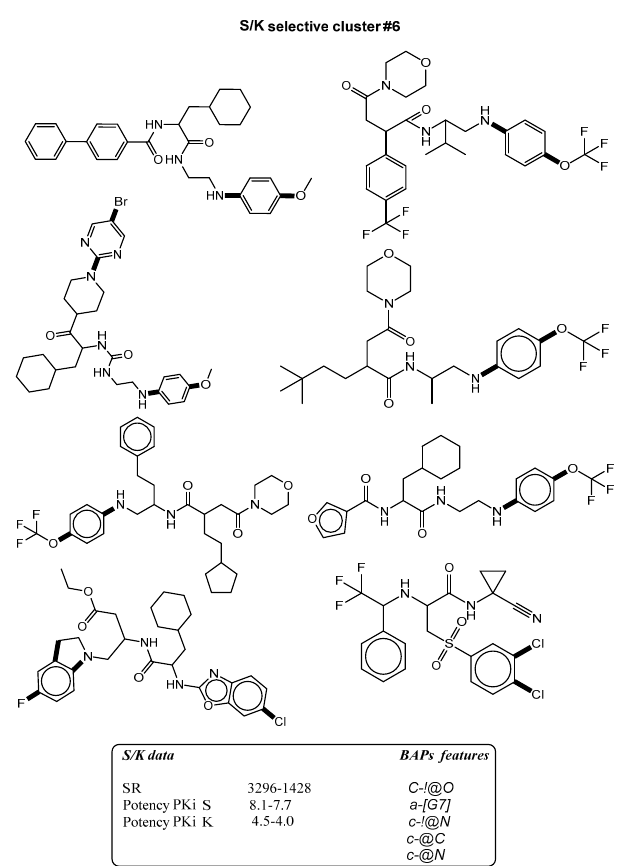
Figure 3. The figure shows mapping of representative BAPS selectivity signatures with high occurrence to S/K selectives presented by bold black highlighting. BAPS featuers are defined as